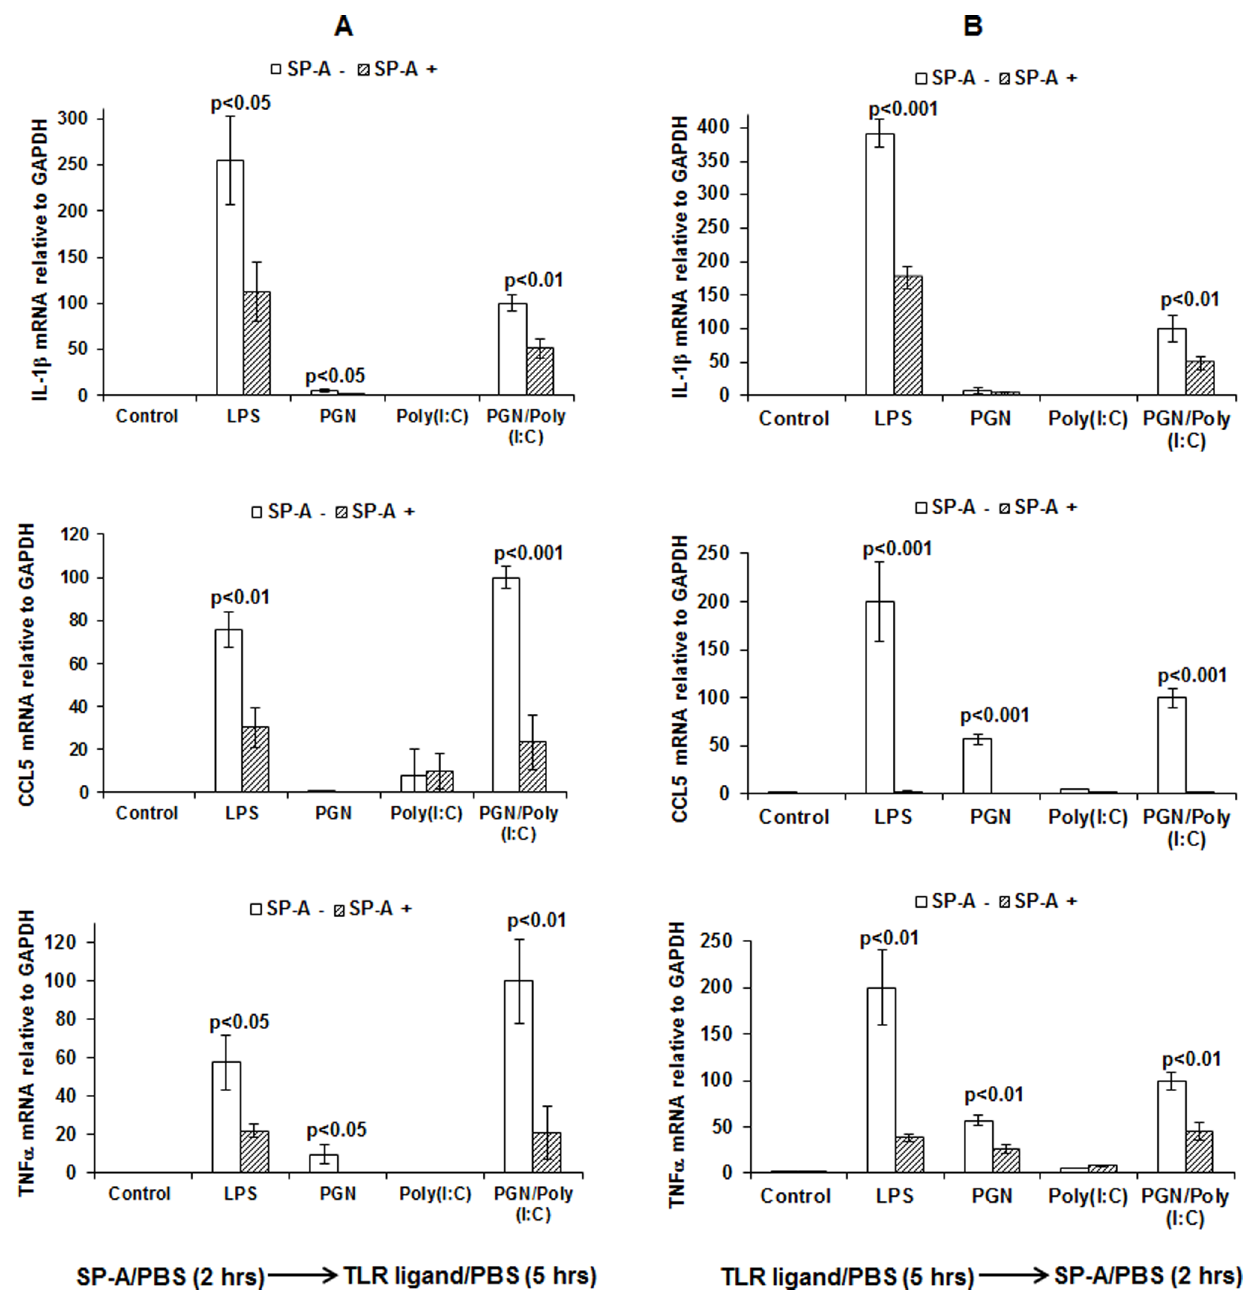
Figure 2. The anti-inflammatory effect of SP-A does not depend upon direct interaction with the stimulating ligand. Expression by RT- PCR of IL-1 b , CCL5 and TNF- a in RAW 264.7 cells after sequential treatment with either SP-A followed by TLR ligand (Panel A) or TLR ligand followed by SP-A (Panel B). (A) initial incubation for 2 hours with PBS or SP-A followed by washing and incubation for an additional 5 hours with PBS, LPS, PGN, poly (I:C) or PGN + poly(I:C).(B) initial incubation for 5 hours with PBS, LPS, PGN, poly (I:C) or PGN + poly(I:C), followed by washing and incubation for an additional 2 hours with either PBS or SP-A. P values were calculated by t-test and compare exposures with and without SP-A. n=3 replicates per condition per experiment. Depicted is a representative figure from three repeat experiments. Error bars=standard deviation. Values for PGN + Poly(I:C) group were set to 100. (20 m g/ml) was studied (i.e. SP-A added either together with, before or after TLR ligands, with an intermediate washing step).